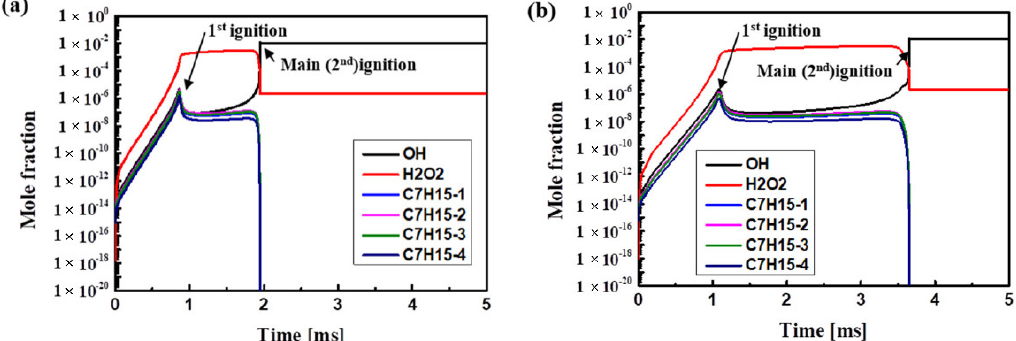
Figure 4. Computed concentrations of various radical species (OH, H 2 O 2 , and C 7 H 15 ) at the condi- tions of Φ = 1.0, P c = 15 bar, CR = 3.5, O 2 = 21% for ( a ) H75M25 and ( b ) H25M75.